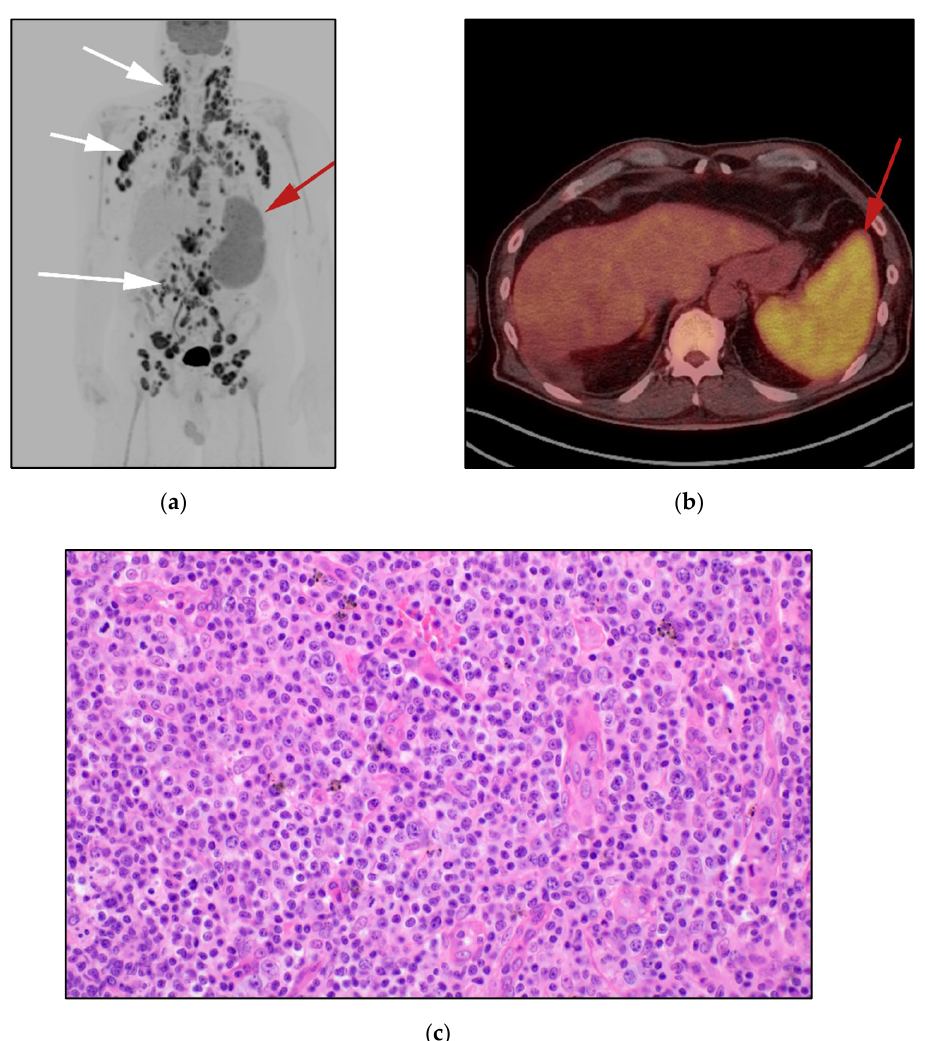
Figure 8. A 77-year-old-male with known diagnosis of AITL ( a , b ) F-18 FDG PET/CT axial images show hypermetabolic adenopathy within the chest (white arrows), as well as hypermetabolic activ- ity within lung nodules (red arrow) ( c ) F-18 FDG PET/CT maximal intensity projection (MIP) image reveals extent of generalized adenopathy throughout the neck, chest, abdomen and pelvis (white arrows) and hypermetabolic splenomegaly (red arrow), consistent with splenic infiltration.( d ) The atypical diffuse infiltrate of pleomorphic lymphocytes is composed of small- and medium-sized cells with rare eosinophils. The neoplastic cells have pale-to-clear cytoplasm. Arborizing blood ves- sels are evident. (Original magnification 400 ×, H&E stain)